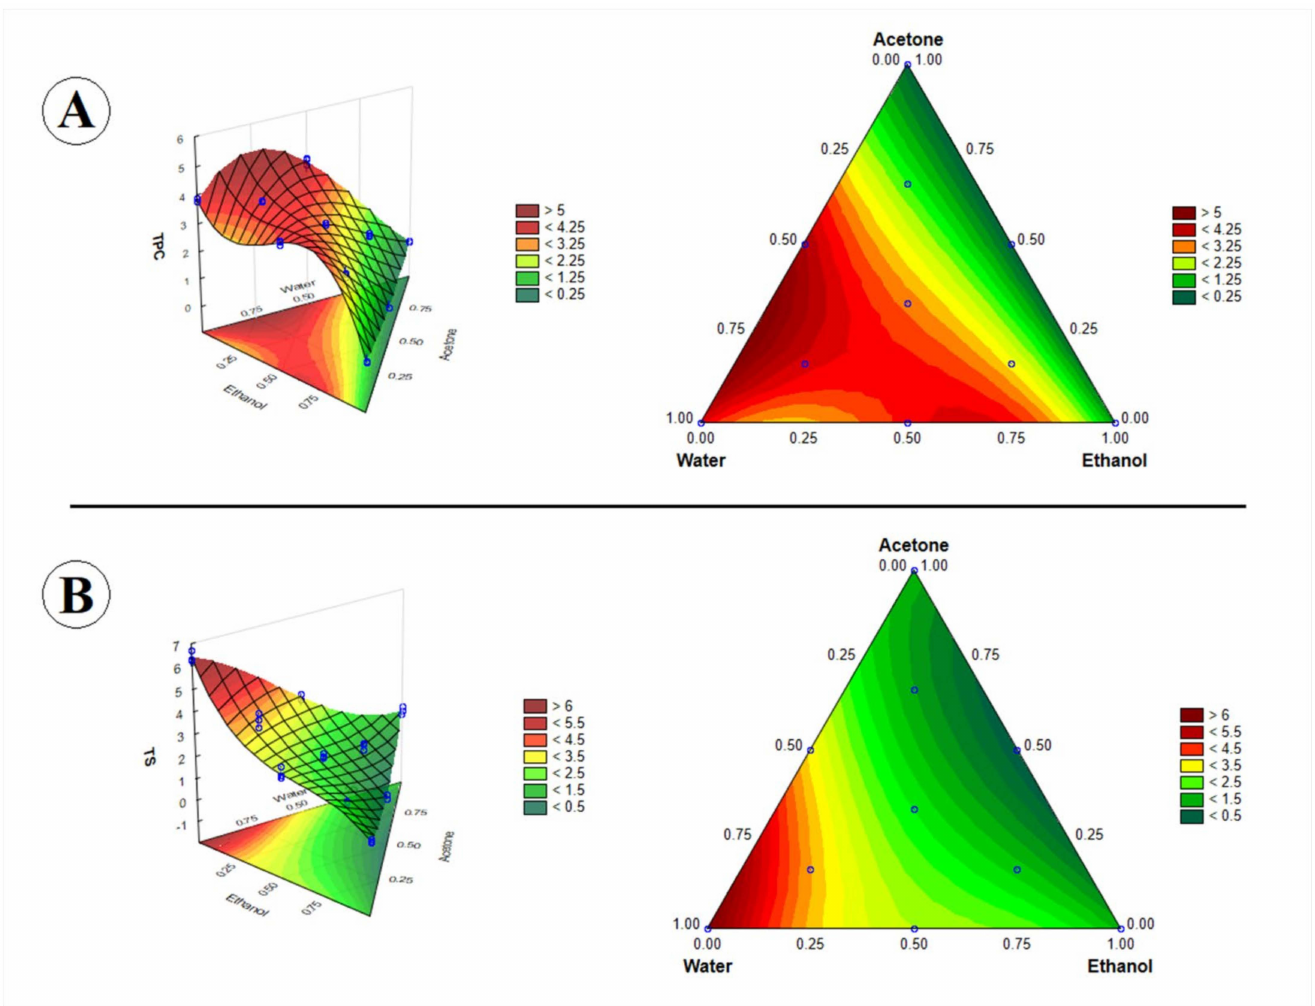
Figure 2. Cubic response surface and contour plot showing the effects of solvent mixture on TPC and TS content. ( A ) total phenolic compound (TPC) content (mg GAE g − 1 DW); ( B ) thiosulfinate (TS) content ( µ mol g − 1